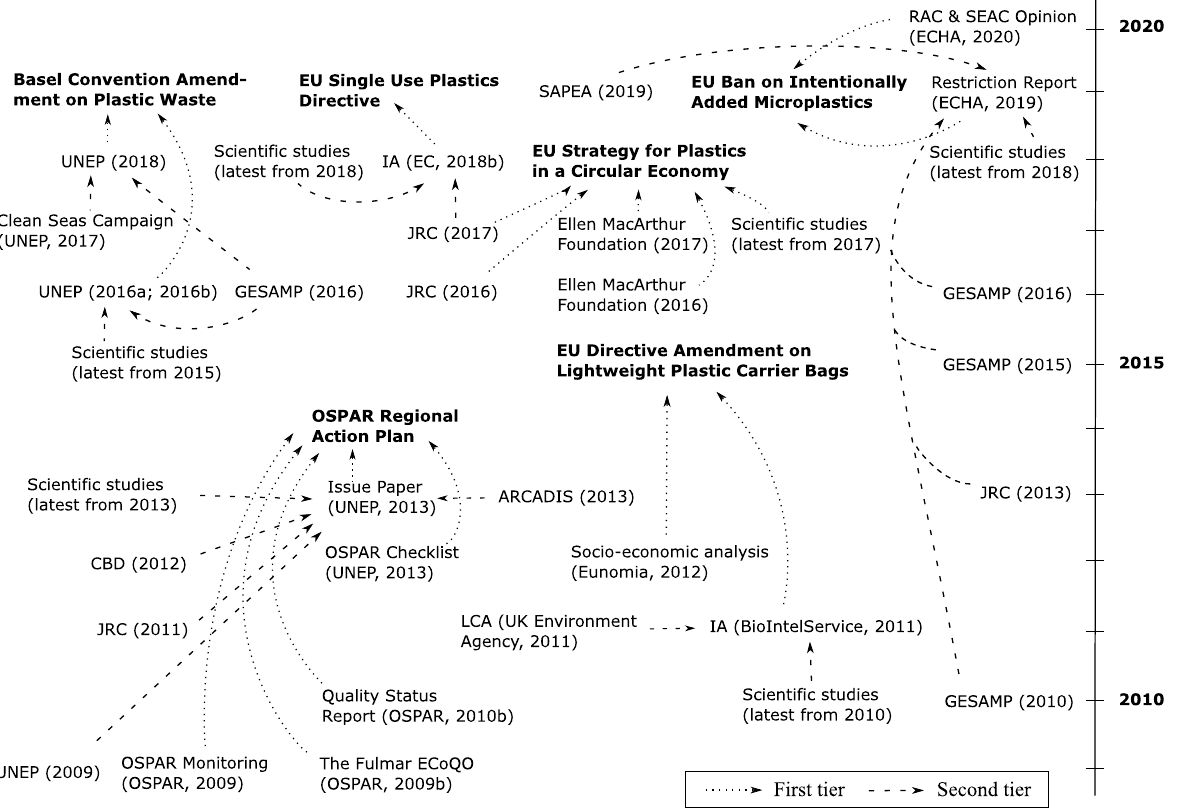
Fig. 1 Historical view of the main pieces of the preparatory work that provides the knowledge foundation for six key policy initiatives targeting plastic pollution. ‘First tier’ documents constitute preparatory work for the initiatives and can be based on ‘second tier’ documents.